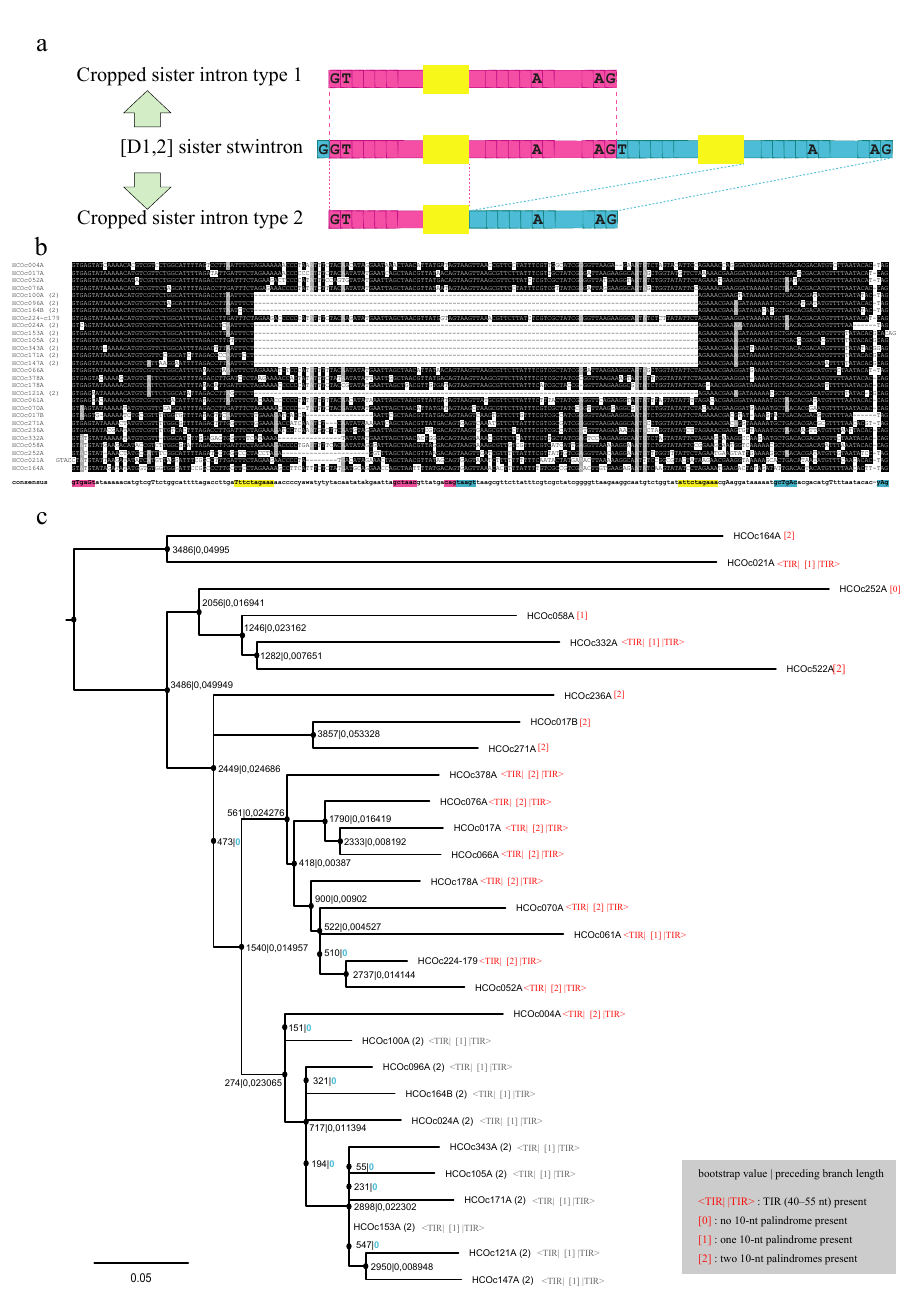
Figure 3. Two types of cropped sister introns derive from different sections of a sister stwintron template. ( a ) Type-1 cropped sister introns (magenta) correspond to the internal introns of sister stwintrons (top), while type-2 cropped sister introns correspond to the 5 (cid:48) half of the internal intron (magenta) fused to the 3 (cid:48) half of the external intron (turquoise) (bottom). The yellow boxes represent the two copies of the 10-nt palindrome 5 (cid:48) WTTCTAGAAA extant in sister stwintrons. Cropped sister introns feature only one such palindrome. ( b ) Alignment of 10 type-2 cropped sister introns with the 18 most similar (D1,2) sister stwintrons. Sequences were aligned and the consensus intron sequence elements (5 (cid:48) -donor; BP-sequnce, 3 (cid:48) -acceptor, 10-nt palindrome) of the constituent canonivcal introns are colour-marked as described in Figure 2. Eight sister stwintron sequences were manually trimmed by removing single nt or longer insertions such that the number of informative nt was 206. None of the type-2 cropped sister intron sequences were manually trimmed. ( c ) Maximum likelihood phylogeny of 19 paralogue sister stwintrons and 10 type-2 cropped sister introns in Hypoxylon sp. CO27-5. The intervening sequences were aligned by MAFFT using the E-INS-i iterative refinement module and